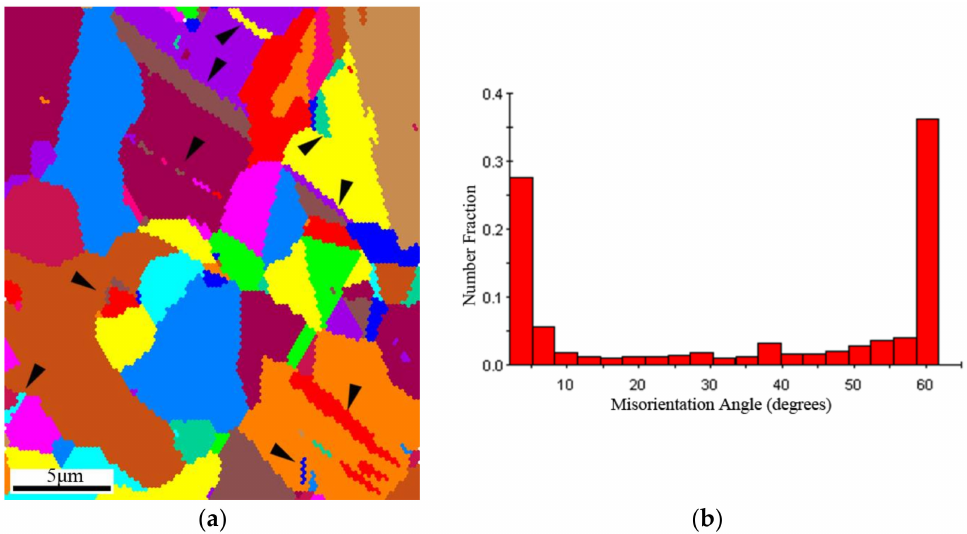
Figure 9. Typical electron backscattered diffraction (EBSD) substructures of recrystallization zone in a Cu-Cr-Zr alloy annealed at 823 K: ( a ) EBSD orientation imaging map; and ( b ) the distribution of grain boundary misorientation